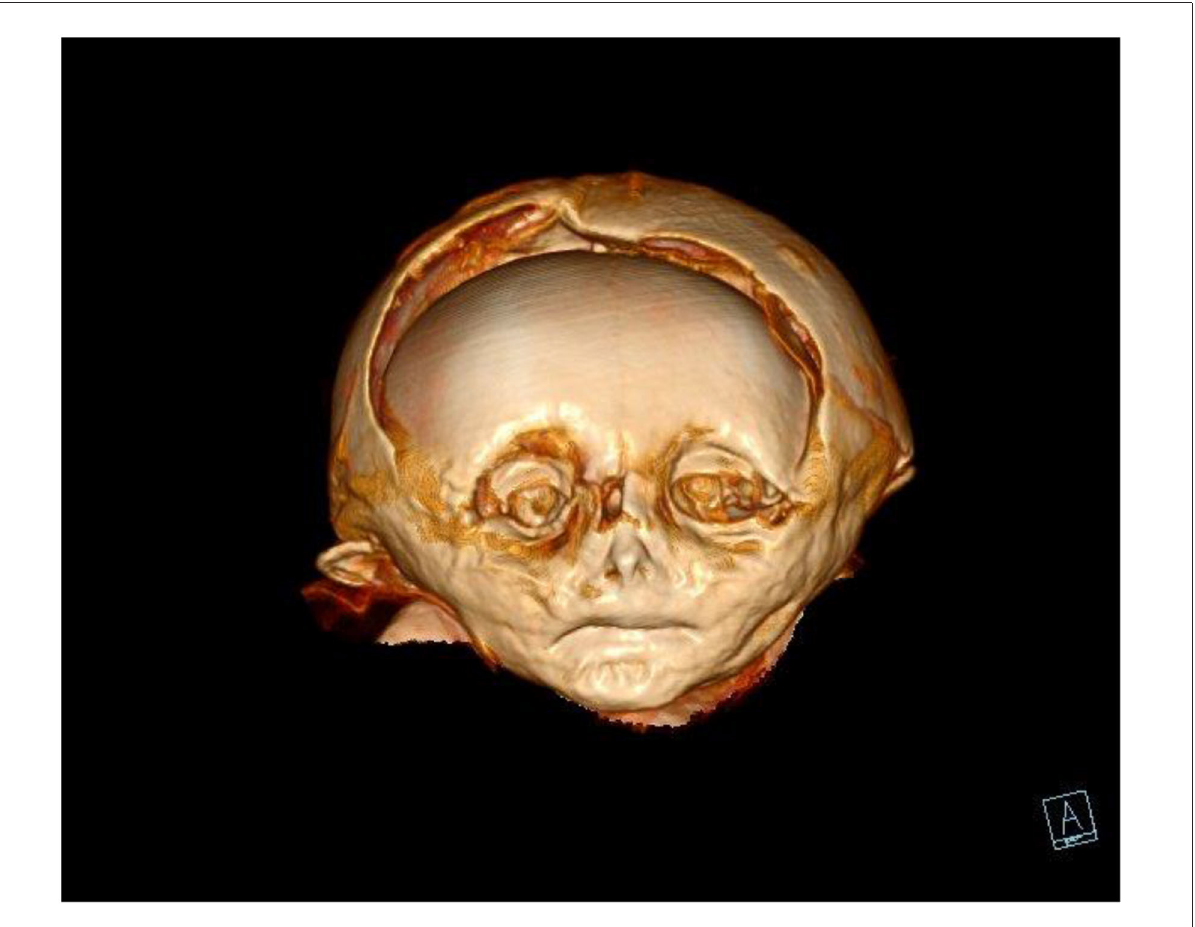
FIGURE6 CT scan of the mummy’s head. On three-dimensional reconstruction, the deformation of the skull bones, especially of the frontal and the parietal squamae are seen.